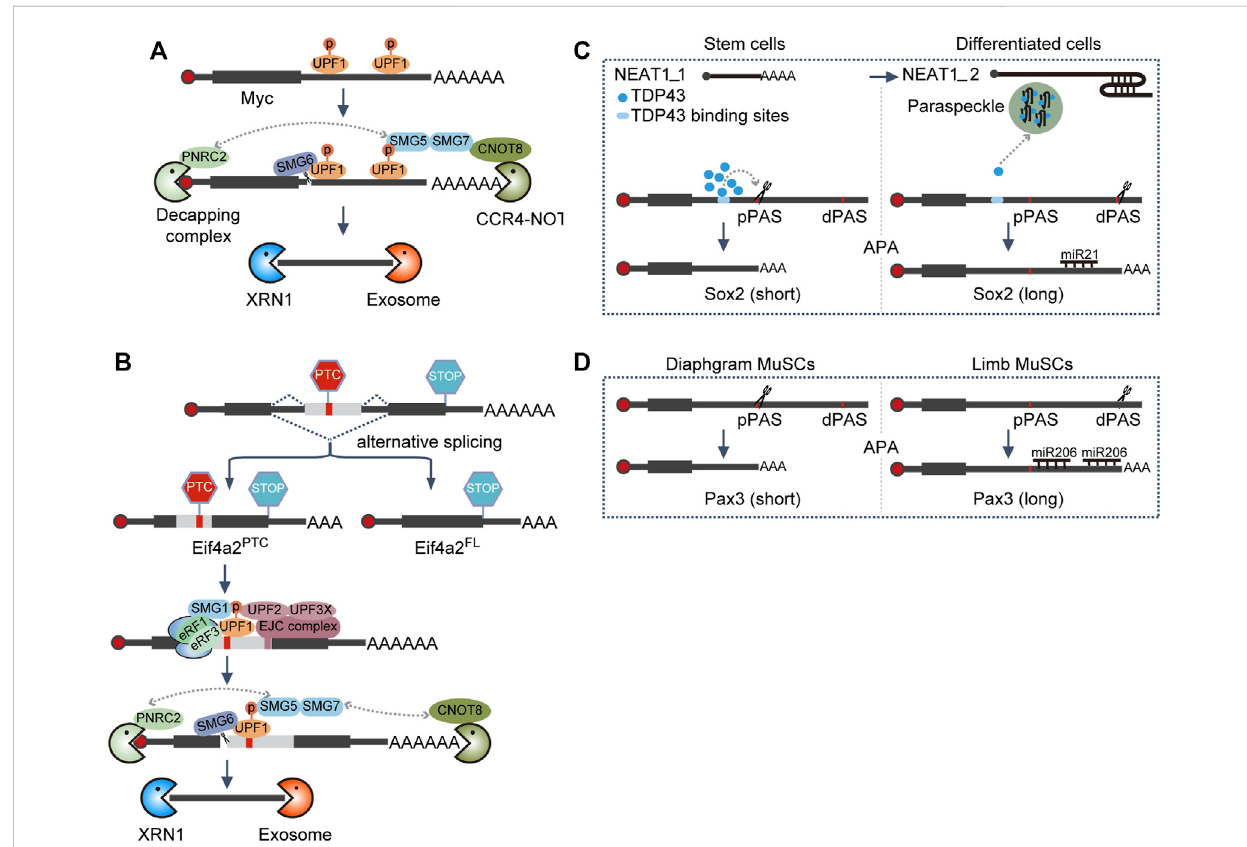
FIGURE 3 Alternative processing coupled RNAdecay. (A) 3 ′ UTR-mediated NMD decay. Phosphorylation of UPF1, present on 3 ′ UTR, is aprerequisite for NMD activation, which inturn will recruit SMG5-SMG7 heterodimer and SMG6. NMD, non-sense-mediated RNA decay; SMG6, RNA endonuclease in the NMD pathway; CCR4-NOT, RNA deadenylation complex; PNRC2, a coactivator for RNA decapping, XRN1, 5 ′ -to-3 ′ RNA exonuclease; exosome , 3 ′ -to-5 ′ RNA exonuclease complex. (B) EJC-mediated NMD decay. PTC, located ≥ 50 – 55 nt upstream of an exon – exon junction, will trigger translation termination and activate the NMD pathway to phosphorylate UPF1, which in turn will recruit the SMG5-SMG7 heterodimer and SMG6. PTC, premature termination codon; STOP, normal stop codon; EJC, exon junction complex, which is assembled ~24 nt upstream of the exon – exon junction, following splicing. (C) APA-mediated RNA degradation regulation of Sox2. TDP43 binds to the element upstream of the pPAS of Sox2 and enhances pPAS processing. Upon differentiation, the transition from NEAT1_1 to NEAT1_2 will facilitate the formation of paraspeckles, ultimately leading to the sequestration of TDP43 and the utilization of dPAS of Sox2. NEAT1_1 and NEAT1_2 are short and long isoforms from gene NEAT1 , respectively. pPAS, proximal polyA site; dPAS, distal polyA site; miR, microRNA; APA, alternative polyadenylation. (D) APA-mediated RNA degradation regulation of Pax3. MuSCs, muscle stem